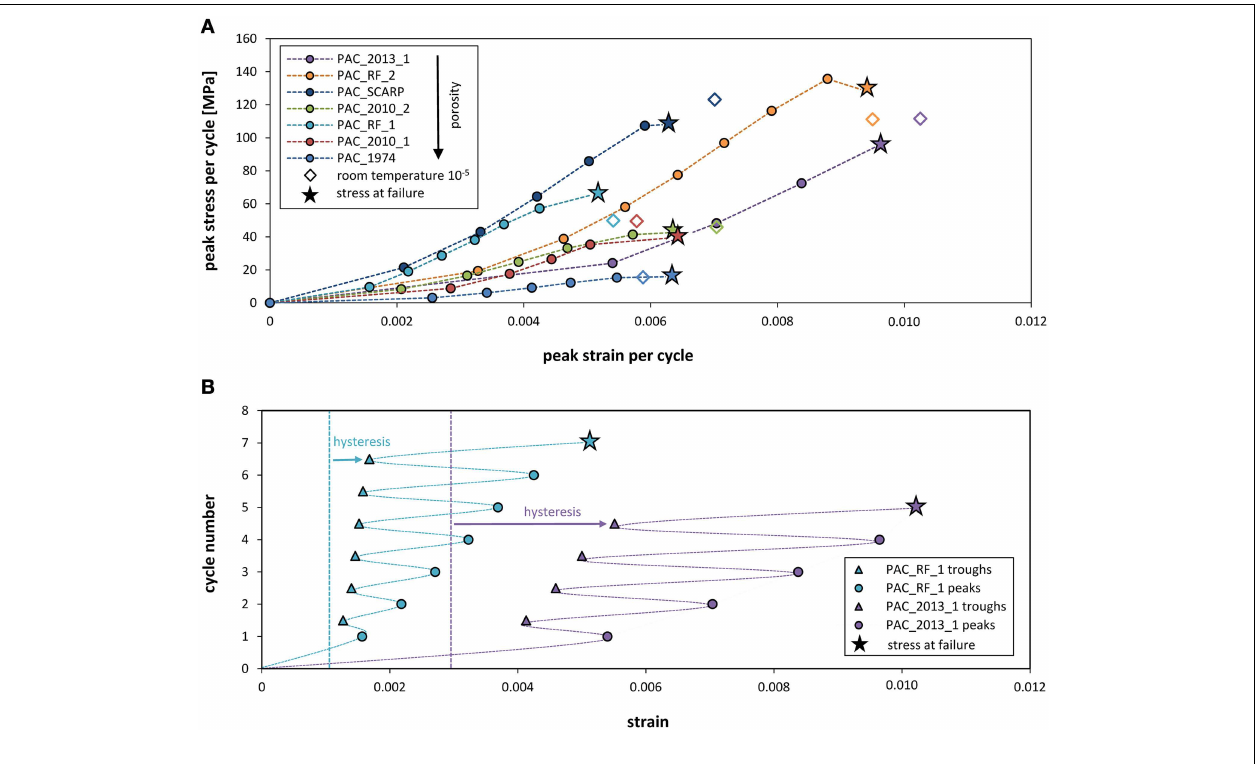
FIGURE 8 | Cyclic loading experiments; (A) Stress-strain evolution for all samples during cyclic loading until failure (shown as a star), as compared to the strength and strain at failure of original (non-thermally stressed) samples determined at room temperature (open diamond). The data shows that generally, the highest porosity